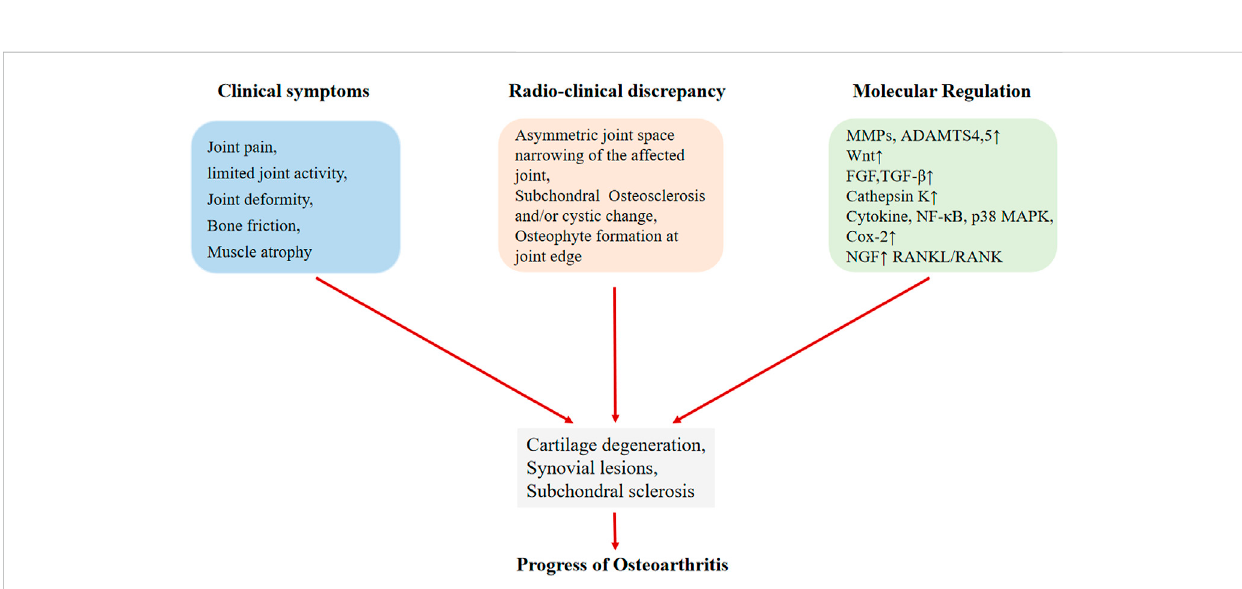
FIGURE 2 The development of osteoarthritis includes clinical symptoms, radiation clinical progress and molecular mechanism